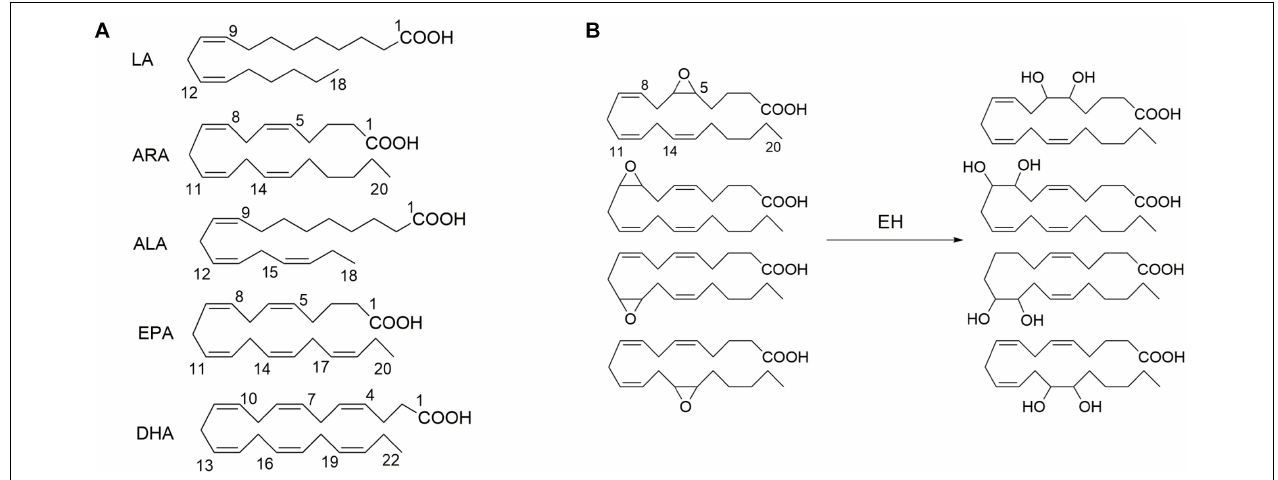
FIGURE 1 | The exemplified polyunsaturated fatty acids (A) that are the common substrates for epoxide hydrolase (EH) and (B) four epoxide regioisomers of ARA that could be metabolized to form the respective diols in the presence of EH such as soluble epoxide hydrolase (sEH) and microsomal epoxide hydrolase (mEH). LA, linoleic acid [18:2 (n–6)]; ARA, arachidonic acid [20:4 (n–6)]; ALA, alpha-linolenic acid [18:3 (n–3)]; EPA, eicosapentaenoic acid [20:5 (n–3)]; and DHA, docosahexaenoic acid [22:6 (n–3)].